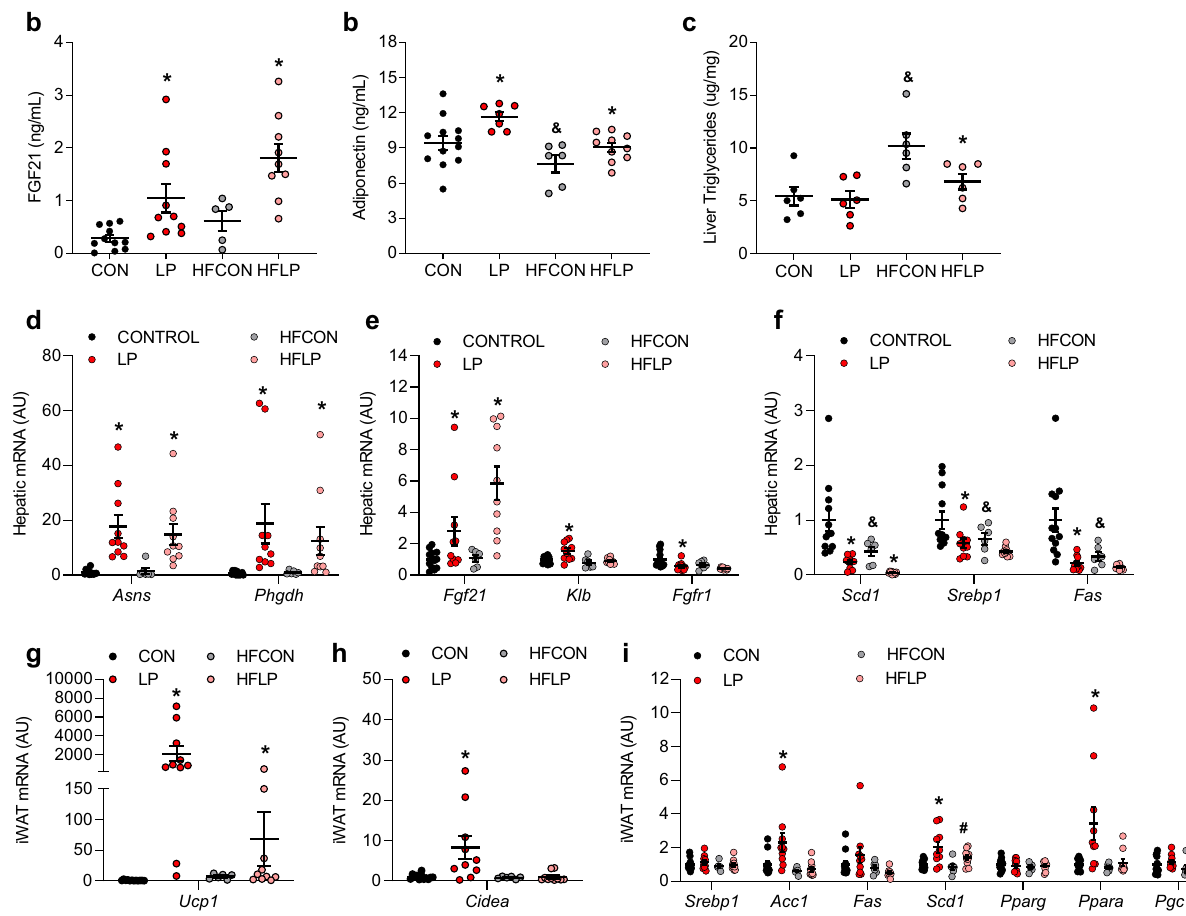
Fig. 8 Serum, liver, and adipose tissue endpoints following the initiation of dietary protein restriction in middle age. a Serum FGF21 concentrations in wildtype and Fgf21 -KO mice consuming control or LP diet from 12 to 16 months of age as Fig. 7a ( n = 6 – 10 mice/group; protein p = 0.0002). b Serum Adiponectin concentrations at 16 months of age ( n = 6 – 10 mice/group; fat p = 0.0007, protein p = 0.004). c Liver triglyceride content at 16 months of age ( n = 6 – 10 mice/group; fat p = 0.0023, protein p = 0.06, fat*protein p = 0.11). d Liver amino acid biosynthetic gene expression (markers of dietary protein restriction) as measured via qPCR at 16 months of age ( n = 6 – 10 mice/group; Asns protein p = 0.003, Phgdh protein p = 0.02). e Liver mRNA expression of FGF21 signaling genes as measured via qPCR at 16 months of age ( n = 6 – 10 mice/group; Fgf21 protein p = 0.01, Klb fat p = 0.001, protein p =